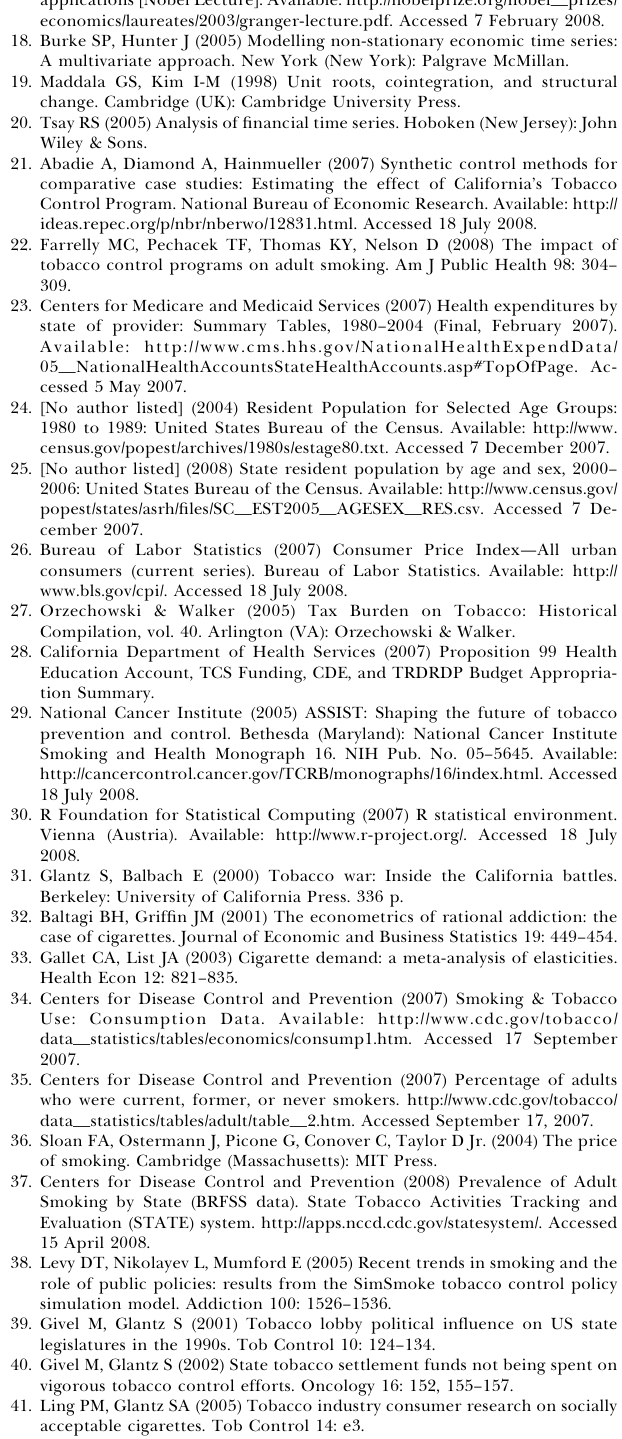
Table S1. Data Used for Analysis Found at doi:10.1371/journal.pmed.0050178.st001 (93 KB PDF). Text S1. Additional Methodological Details and Sensitivity Analysis Found at doi:10.1371/journal.pmed.0050178.sd007 (219 KB